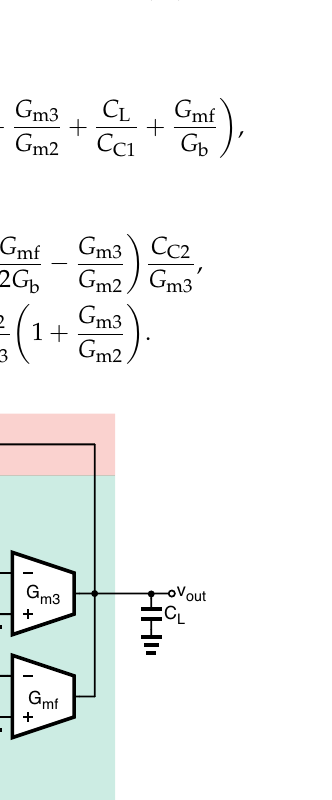
Figure 11. Block schematic of a three-stage OTA compensated with the Reversed Nested-Miller Compensation with Inverse Current Buffer and Feed-Forward stage (RNMC-ICBFF). Referring to the block schematic in Figure 1a, we can identify (1) the block responsible for the dominant pole and the GBW of the amplifier (light-yellow area); (2) the internal block with two real poles (light-green area); (3) the internal feedback across the internal block (light-red area). The overall feedback that will connect the output v out to the input v in is not